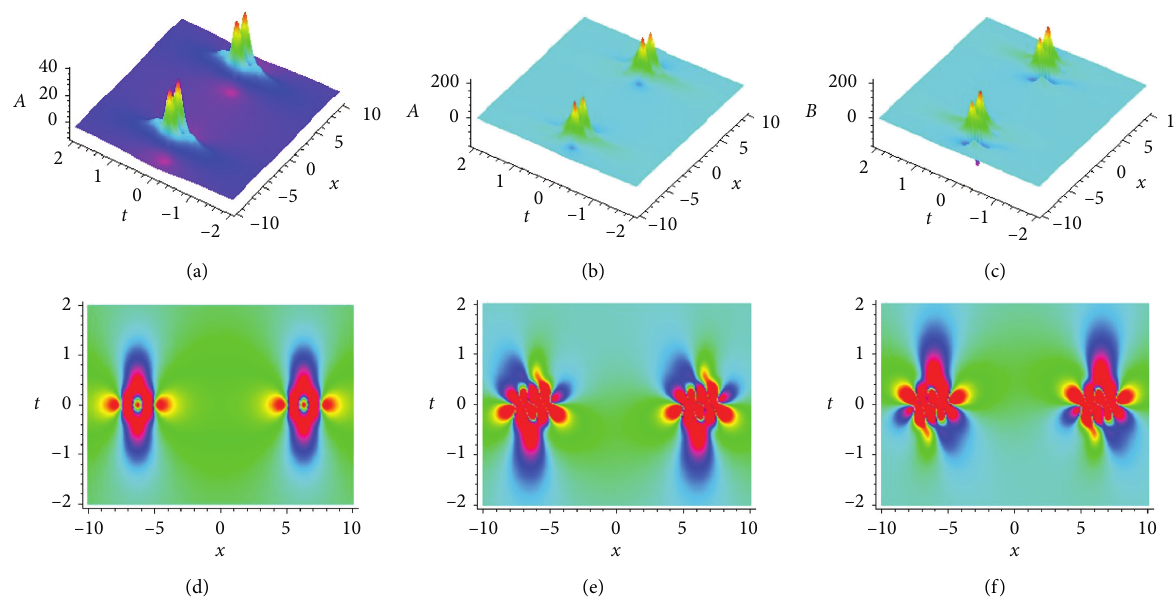
Figure 8: The second-order x -breather solution of equation (36) with (a) b density plots of (a)–(c),